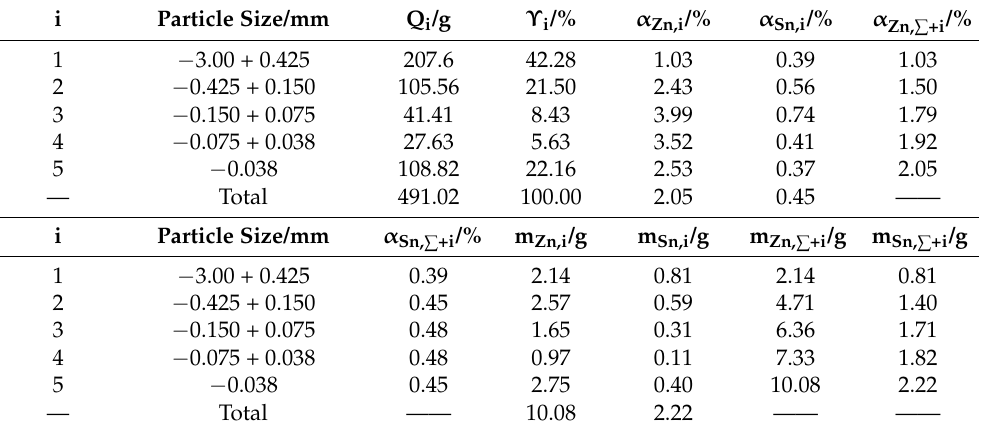
Table 3. The analysis results of grinding product when grinding time is 2 min.